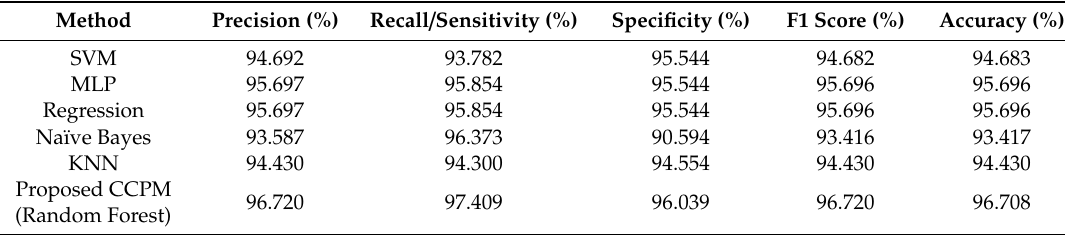
Table 7. Performance evaluation results based on DBSCAN and SMOTETomek for Biopsy.